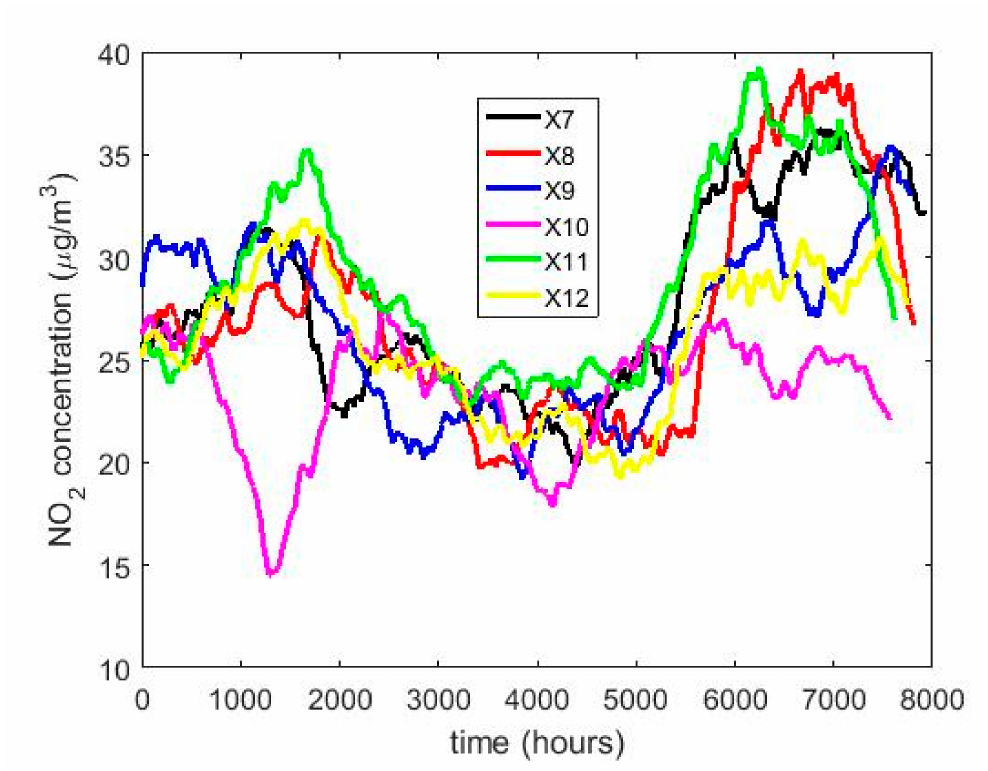
Figure 4. Moving average of the NO 2 concentration measurements during the years from 2014 to 2019: X 7 ( 2014 ) , X 8 ( 2015 ) , X 9 ( 2016 ) , X 10 ( 2017 ) , X 11 ( 2018 ) , and X 12 ( 2019 )